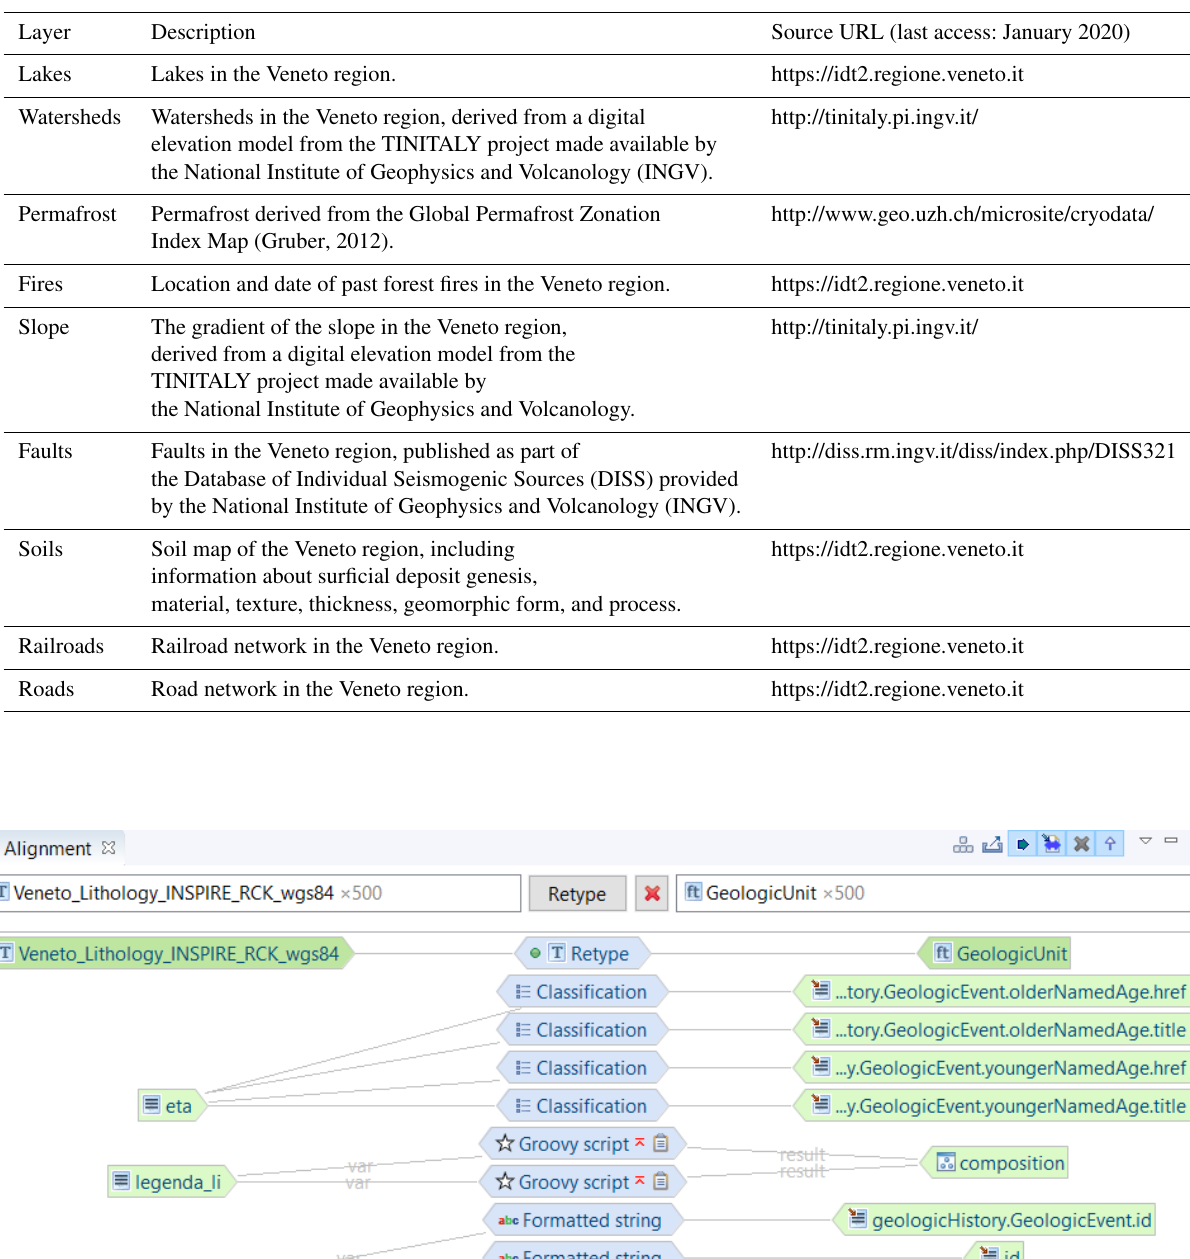
Table 3. Layers not compliant with INSPIRE standards.